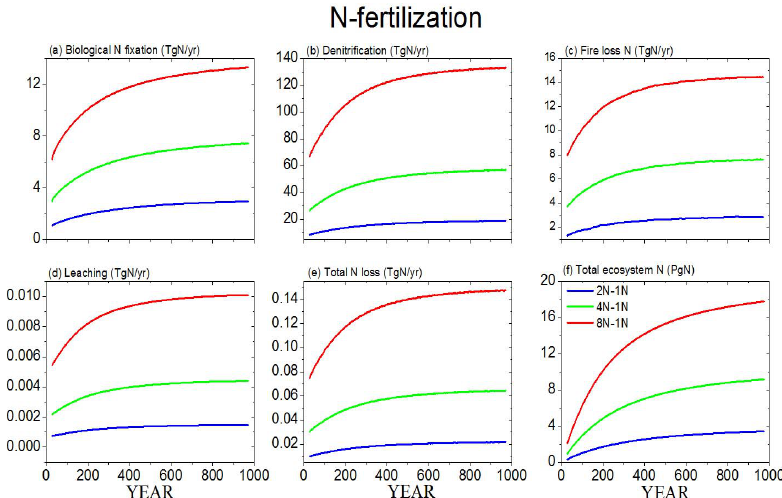
Fig. 5. Changes in N budget for the terrestrial ecosystem in 2N (blue line), 4N (green line) and 8N (red line) simulations relative to 1N: changes in annual mean (a) biological N fixation (BNF), (b) denitrification, (c) fire loss N, (d) leaching, and (e) the total N loss from ecosystem (sum of denitrification, fire loss N and leaching). Total ecosystem N (f) is the cumulative sum of BNF and N deposition (constant in time for all simulations) minus cumulative sum of total N loss from ecosystem. A 57yr running average is applied to original annual mean